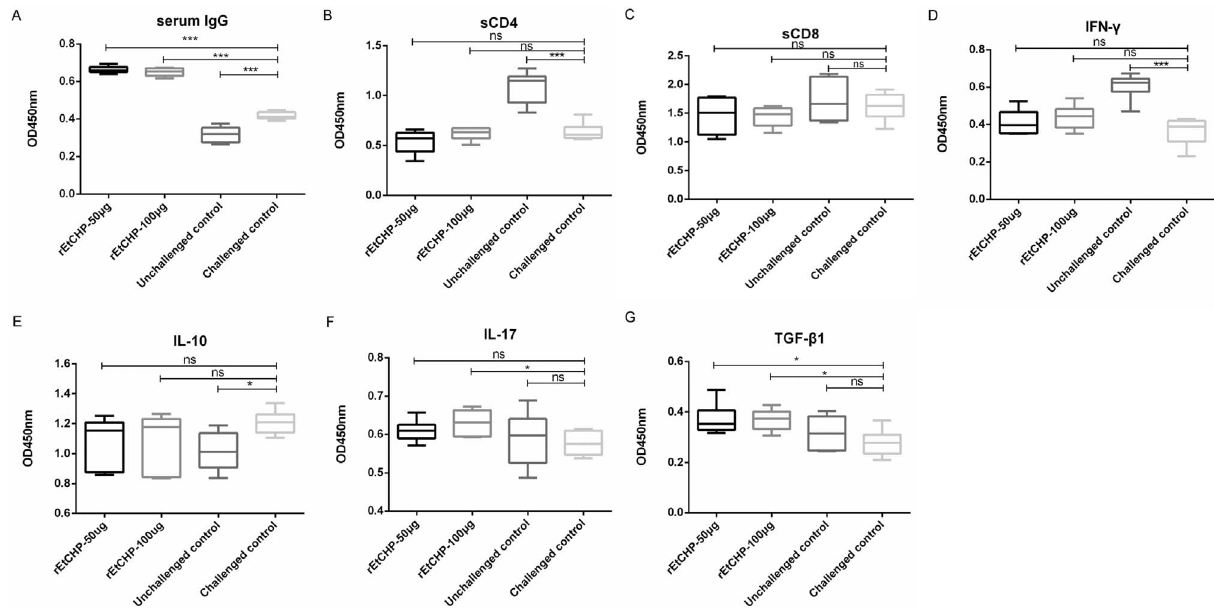
Figure 8. Levels of IgG (A), sCD4 (B), sCD8 (C), cytokines IFN- c (D), IL-10 (E), IL-17 (F) and TGF- b 1 (G) in chicken sera were measured using ELISA. Chickens of group r Et CHP18905-50 l g and group r Et CHP18905-100 l g were immunized with 50 l g or 100 l g of r Et CHP18905 protein, respectively. Challenged and unchallenged groups were immunized with PBS and served as controls. The IgG titers and the concentrations of sCD4, sCD8, and cytokines are expressed as Min to Max. (* p < 0.05, ** p < 0.01, *** p < 0.001; ns, p >